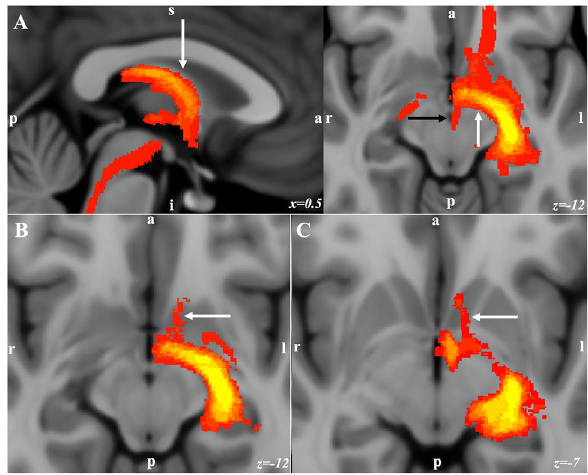
Figure 7. Population connectivity maps of the amygdala clusters. ( A ) The medial and basal clusters showed stronger connectivity through the stria terminalis (arrow in sagittal view) and ventral amygdalofugal pathway (arrow in axial view). These two pathways converged in the BNST, hypothalamus, and septal area. The medial cluster showed unique connectivity with the ventral tegmental area through the medial forebrain bundle (black arrow in axial). ( B ) and ( C ) The medial and lateral cluster showed stronger connectivity with ventral and dorsal areas of the NAc respectively.